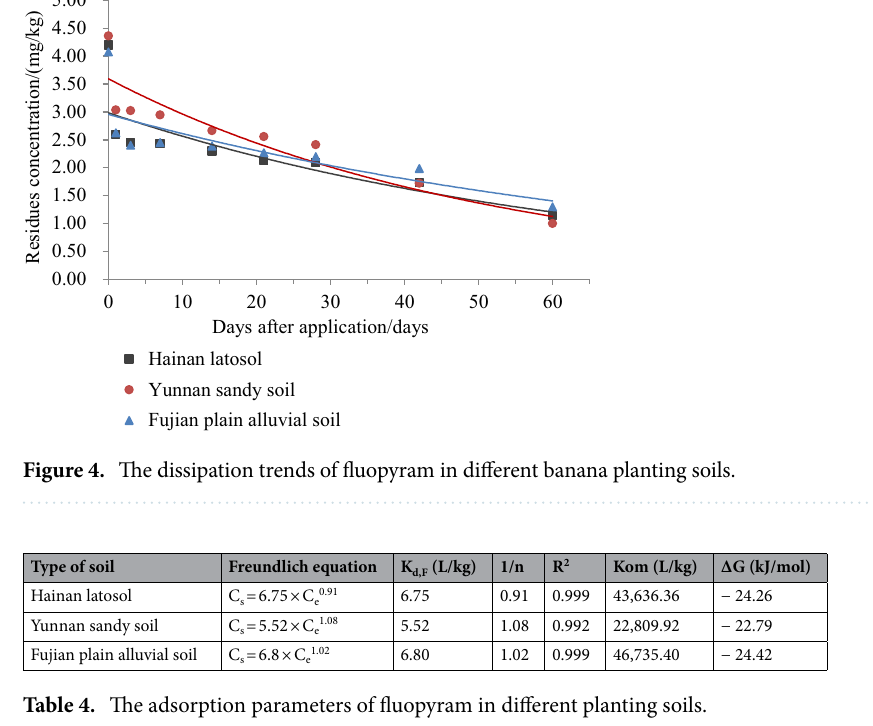
Table 4. The adsorption parameters of fluopyram in different planting soils.